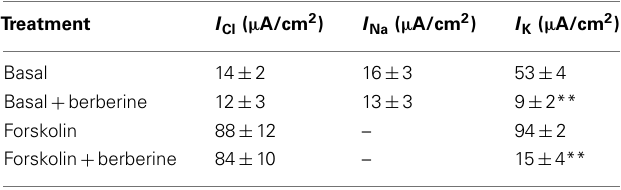
Table 2 | Berberine effect on membrane conductances.